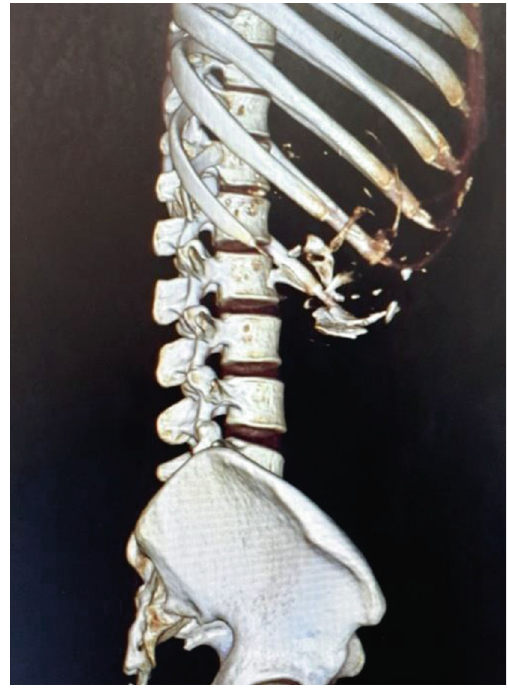
Figure 2: Three-dimensional reconstruction CT image showing bony outlines of fetus in